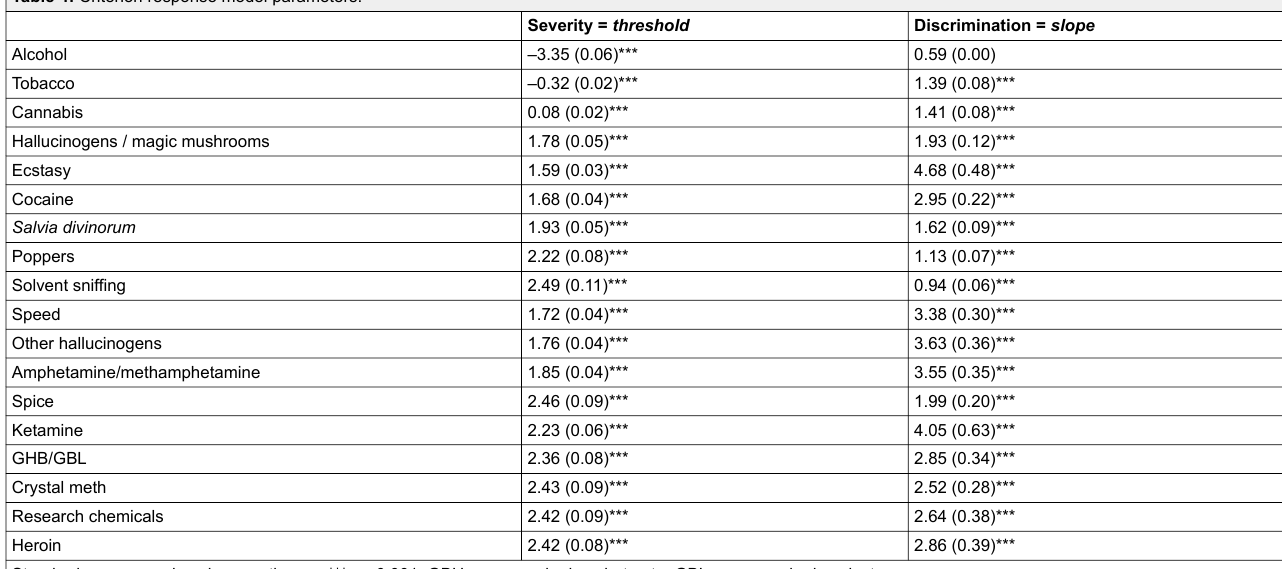
Table 4: Criterion response model parameters.